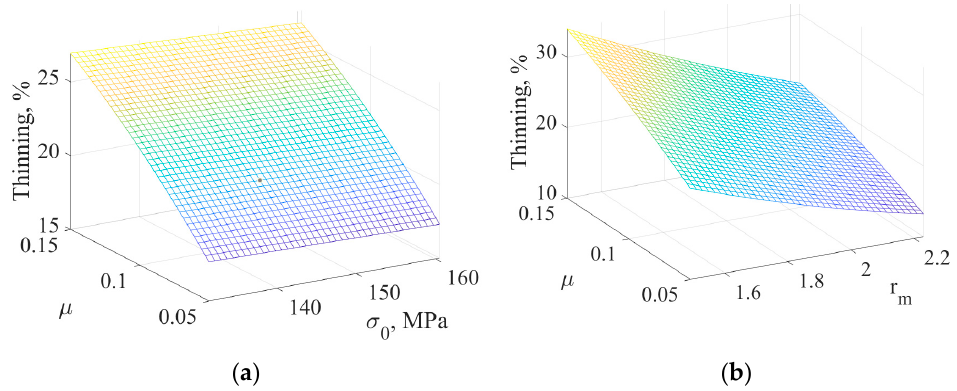
Figure 12. Metamodel of thinning percentage for a fluctuation in ( a ) µ and 𝜎 (cid:2868) and ( b ) µ and 𝑟 (cid:3040) .